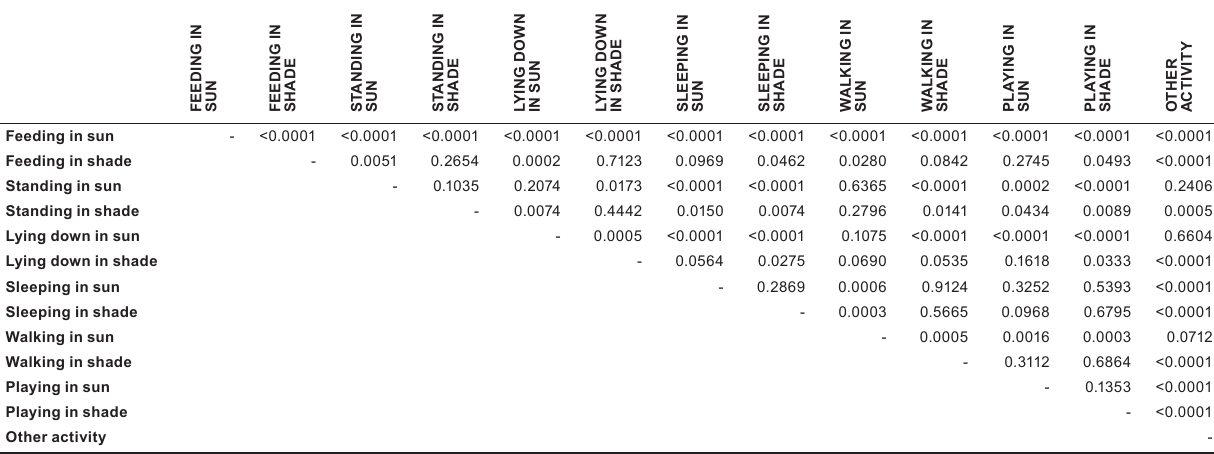
Table 1 P-values of comparative tests between sets of two variables (activities) to examine independence of the frequency of different activities in springbok herds from November 2002 to May 2004 in the Kalahari Gemsbok National Park. Statistical independence is where p ≤